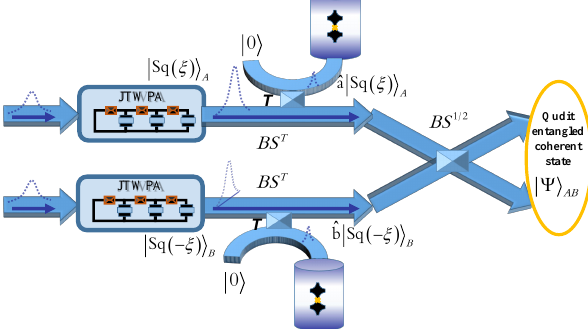
Figure 4. Extended schematics for generating a traveling qudit entangled coherent state (ECS) for d = 4 in circuit-QED. The last BS 1/2 makes entanglement between two